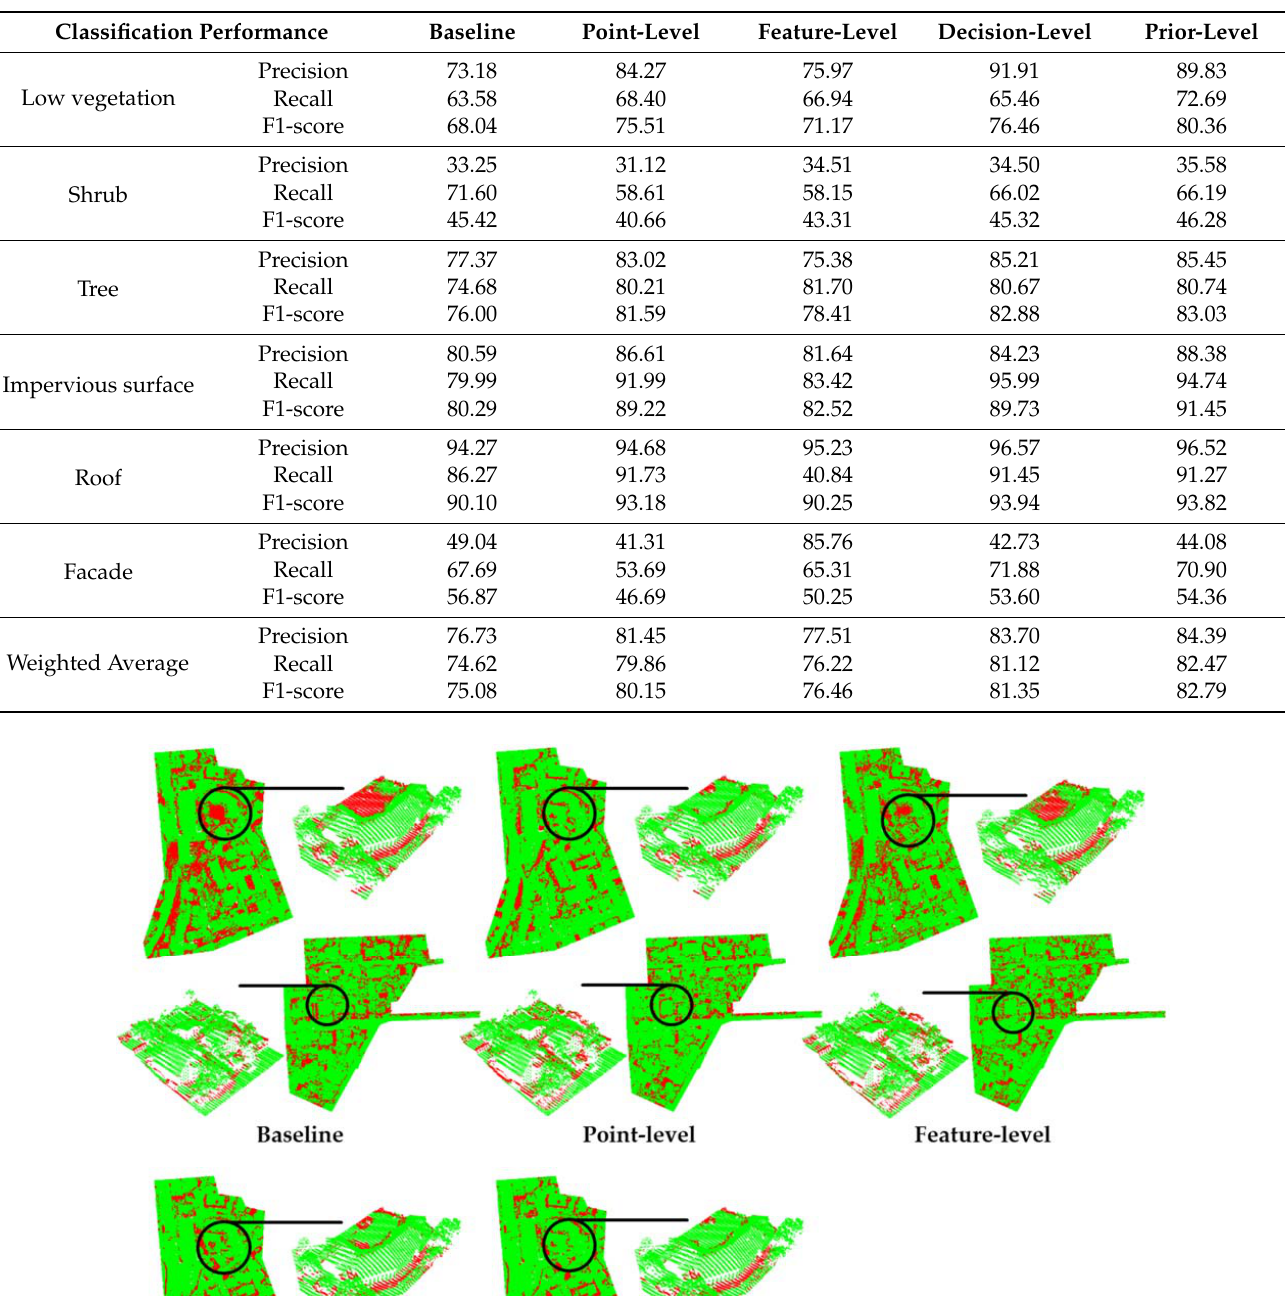
Table 2. Classification performance of the baseline and four fusion strategies.